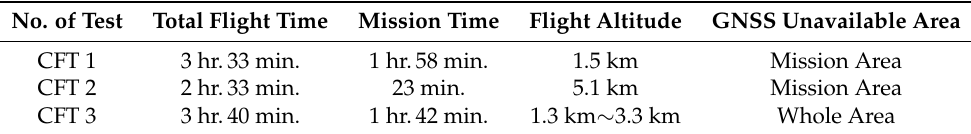
Table 3. Conditions of captive flight tests.